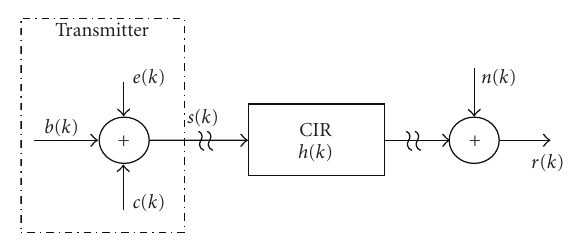
Figure 1: SISO digital communication system